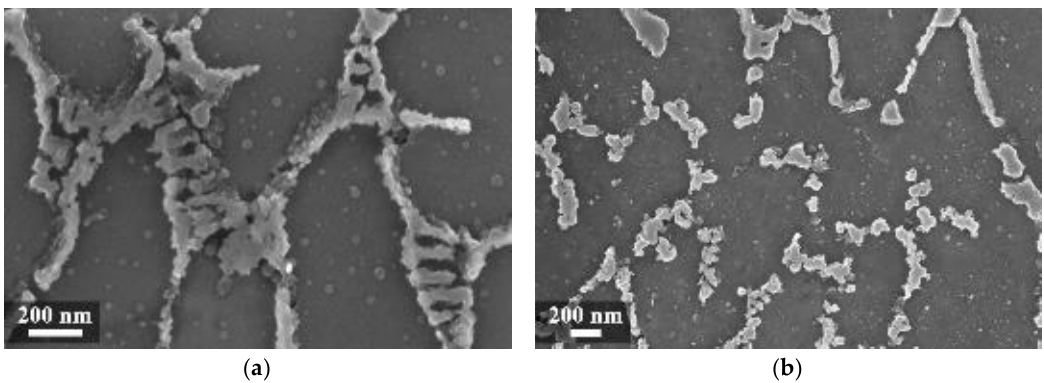
Figure 8. ( a ) Close-up of the eutectic-like phase on the border of α -Al grains and ( b ) idiomorphic crystals in the HAZ of the as-built specimens (T platform 100 °C).